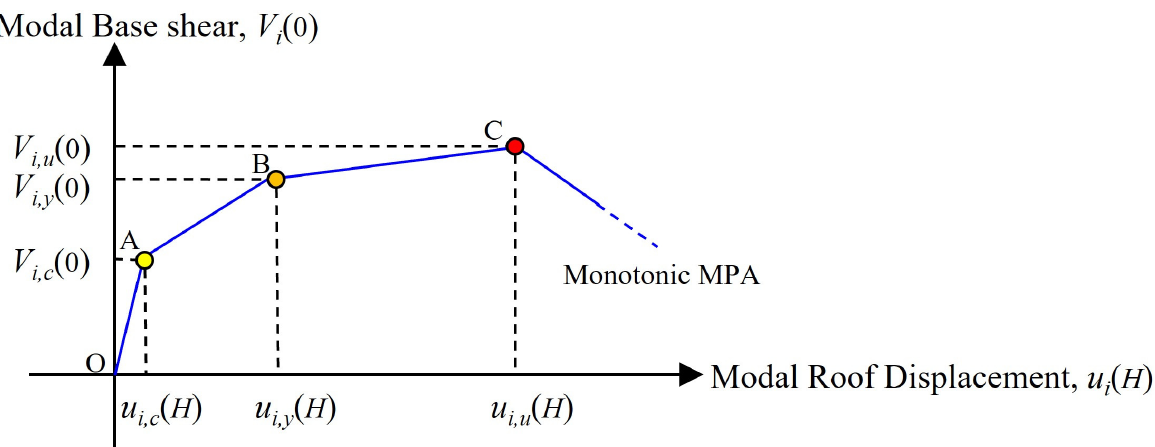
Figure 8. Generalized capacity curve.